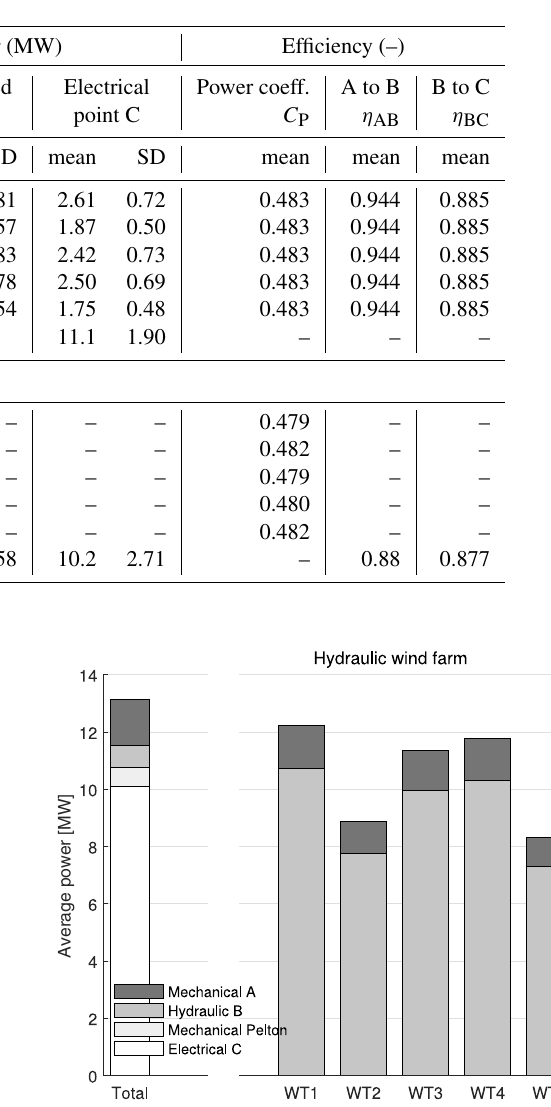
Table 3. Performance overview of time domain results for below rated conditions.